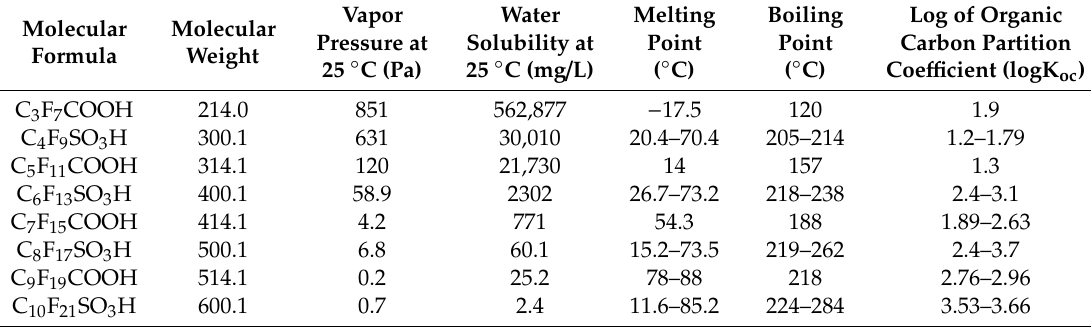
Table 1. Physical and chemical properties of selected PFAS, adapted from ITRC PFAS Team [51].